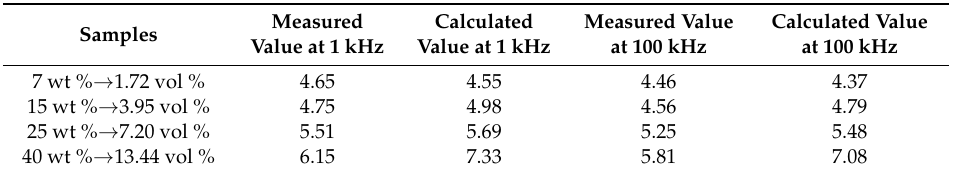
Table 1. Dependencies of dielectric constants on volume fractions based on Lichtenecker’s logarithmic mixture formula compared with the measured